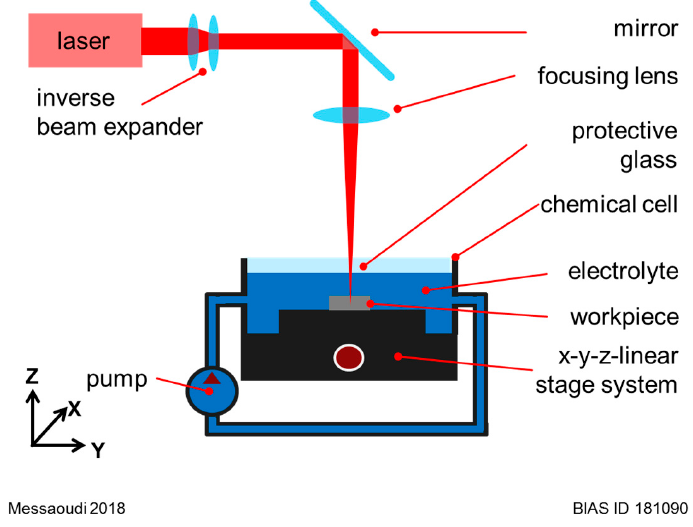
Figure 1. Schematic illustration of the main steps used to determine the removal cavity characteristics: removal depth d rem , width w rem and volume V rem .